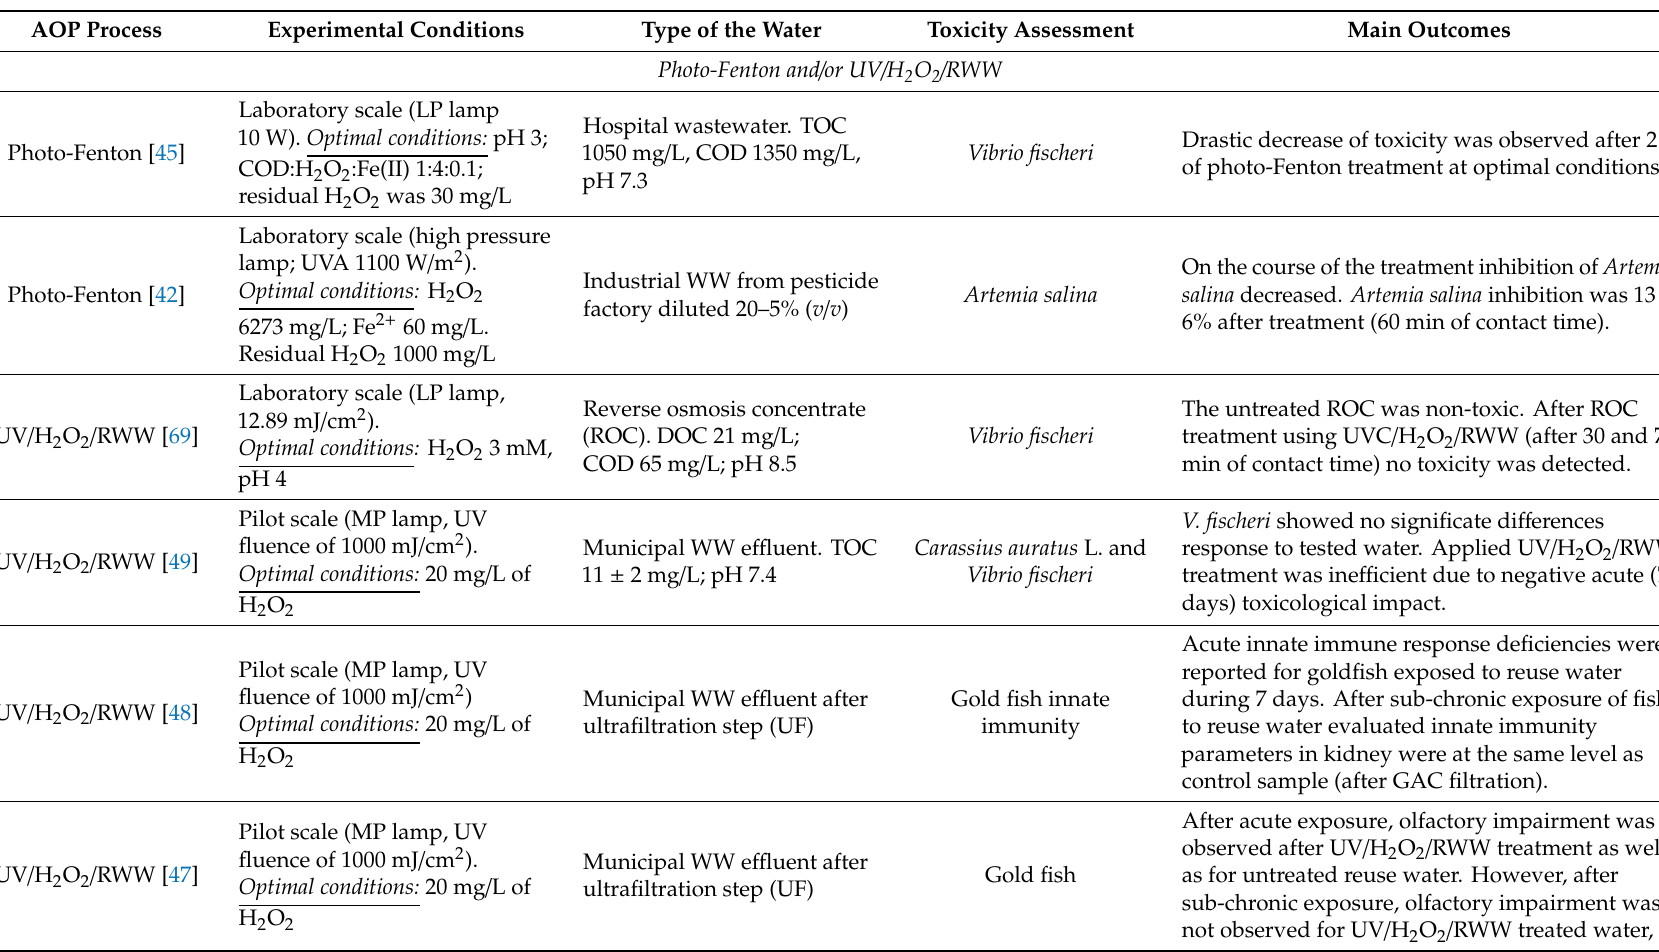
Table 3. Toxicity bioassays applied for assessment of wastewater detoxification after photo-Fenton, electro-Fenton and other Fenton-based advanced oxidation processes